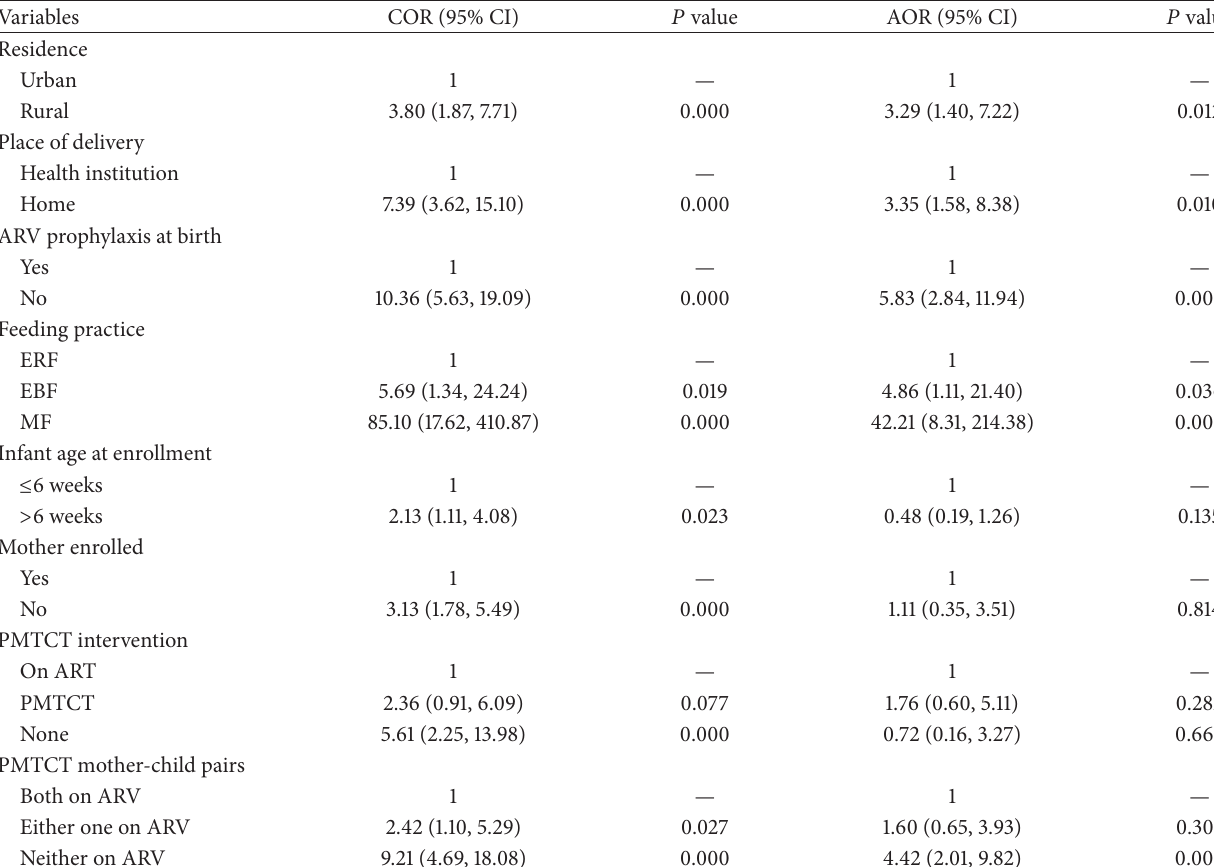
Table 2: Determinants of mother-to-child transmission of HIV infection among exposed infants on follow-up care in Dire Dawa, Ethiopia, September